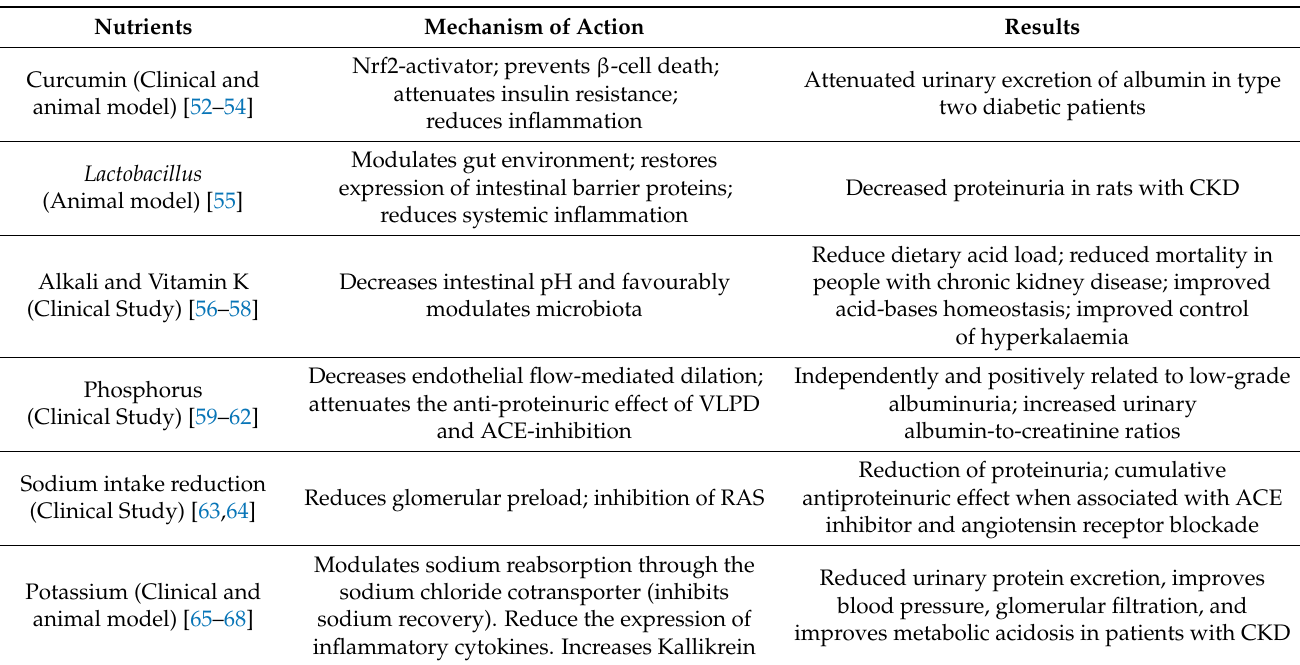
Table 2. Mechanism of action and results of different nutrients in proteinuria